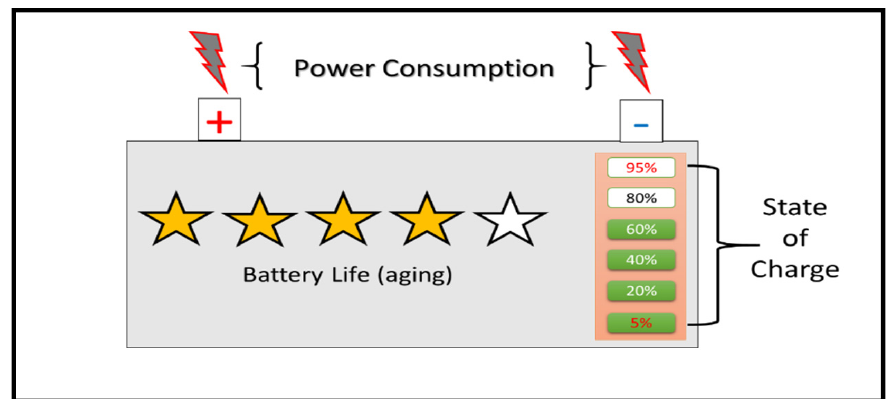
Figure 3. Power consumption control.